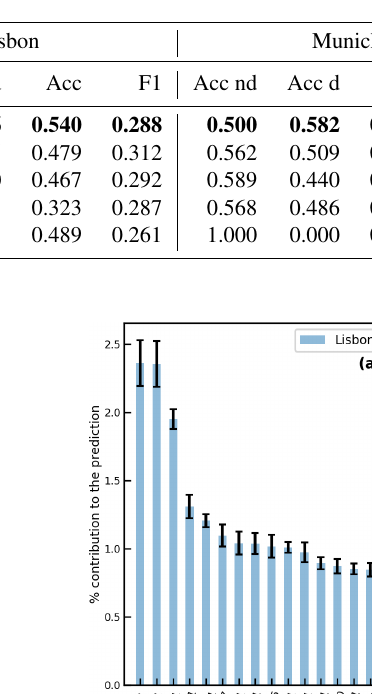
Table 4. Performance of the model for different loss functions for the test dataset. Acc nd refers to the accuracy on the non-drought class and Acc d to the accuracy of the drought class. Mean absolute error (bold) is chosen for subsequent analysis since for Munich and Lisbon it shows an accuracy of at least 0.5 for both classes and a higher performance with regards to the F1 score.